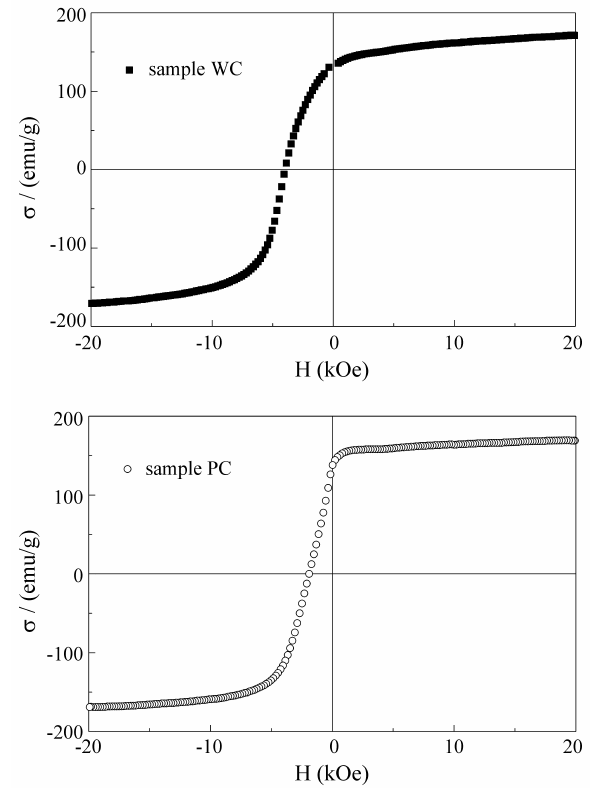
Figure 5. Specific magnetization σ vs. applied field H for WC sample and PC sample undergoing 30 s flash